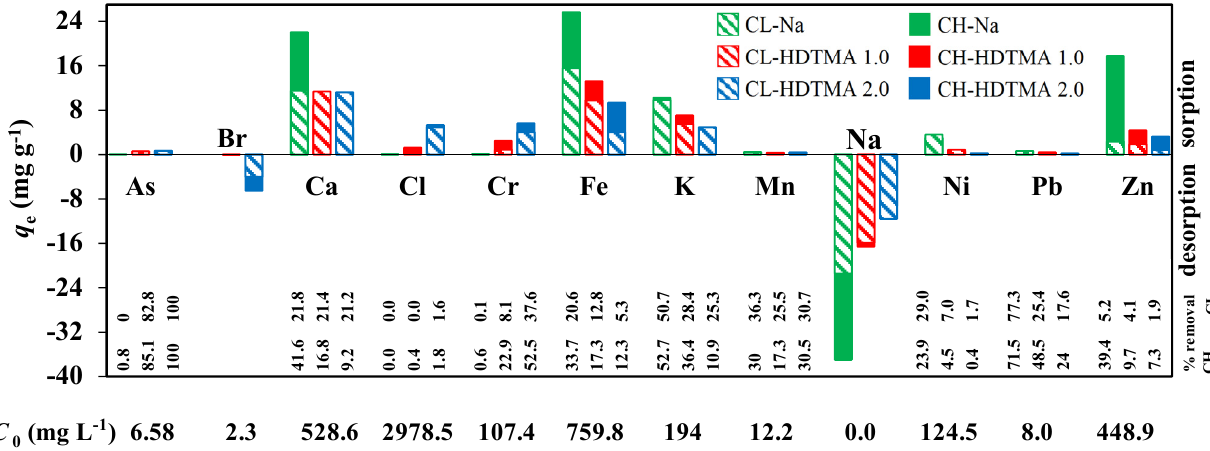
Figure 11. Efficiency of wastewater treatment by SMZs.